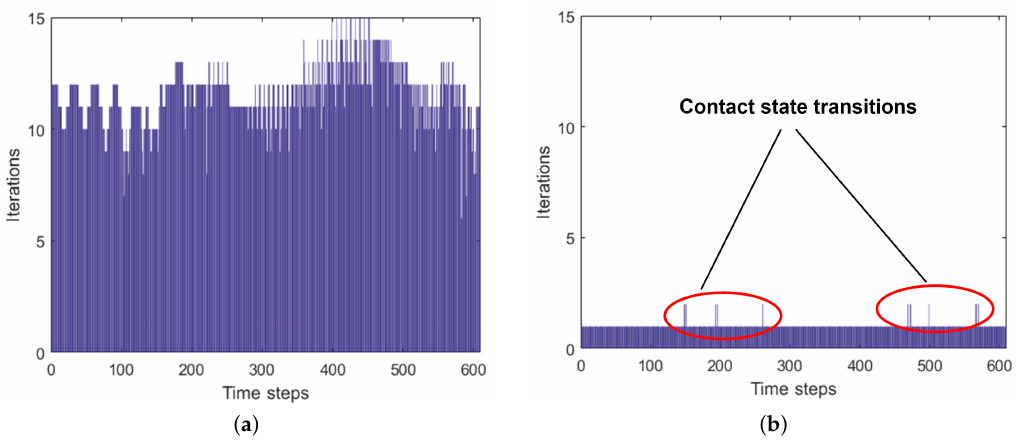
Figure 5. Histogram representing the number of iterations per time step of the predictor-corrector scheme implemented in the DTI algorithm: ( a ) constant displacement assumption; ( b ) unchanged contact state